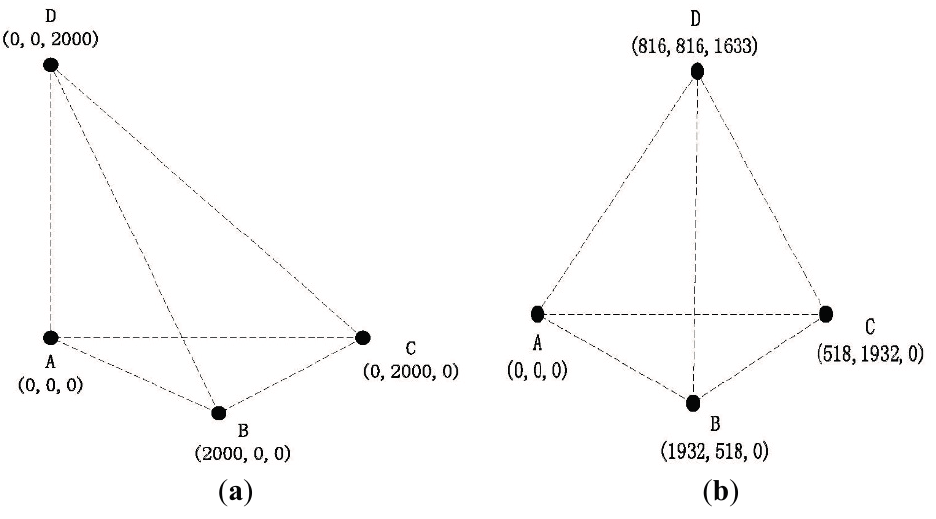
Figure 8. Anchors’ deployment: ( a ) Senario 1; and ( b ) Scenario 2 (normal triangular